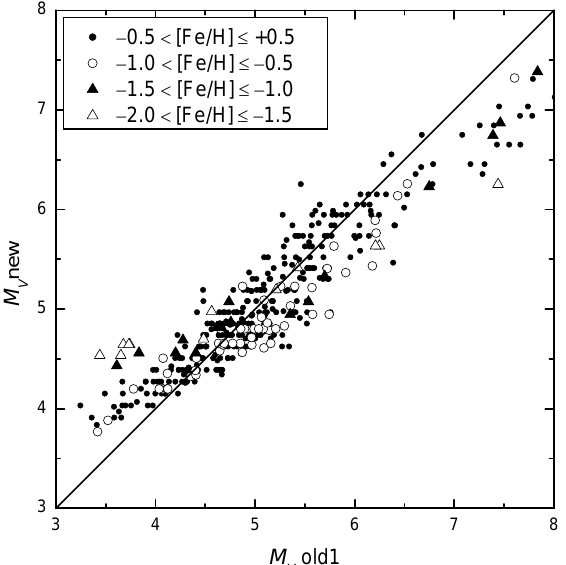
Fig. 4. Comparison of the absolute magnitudes M V calculated using the old (pre- Hipparcos ) calibration (formula (1) of Lazauskait˙e 1995) and the new calibration given in this